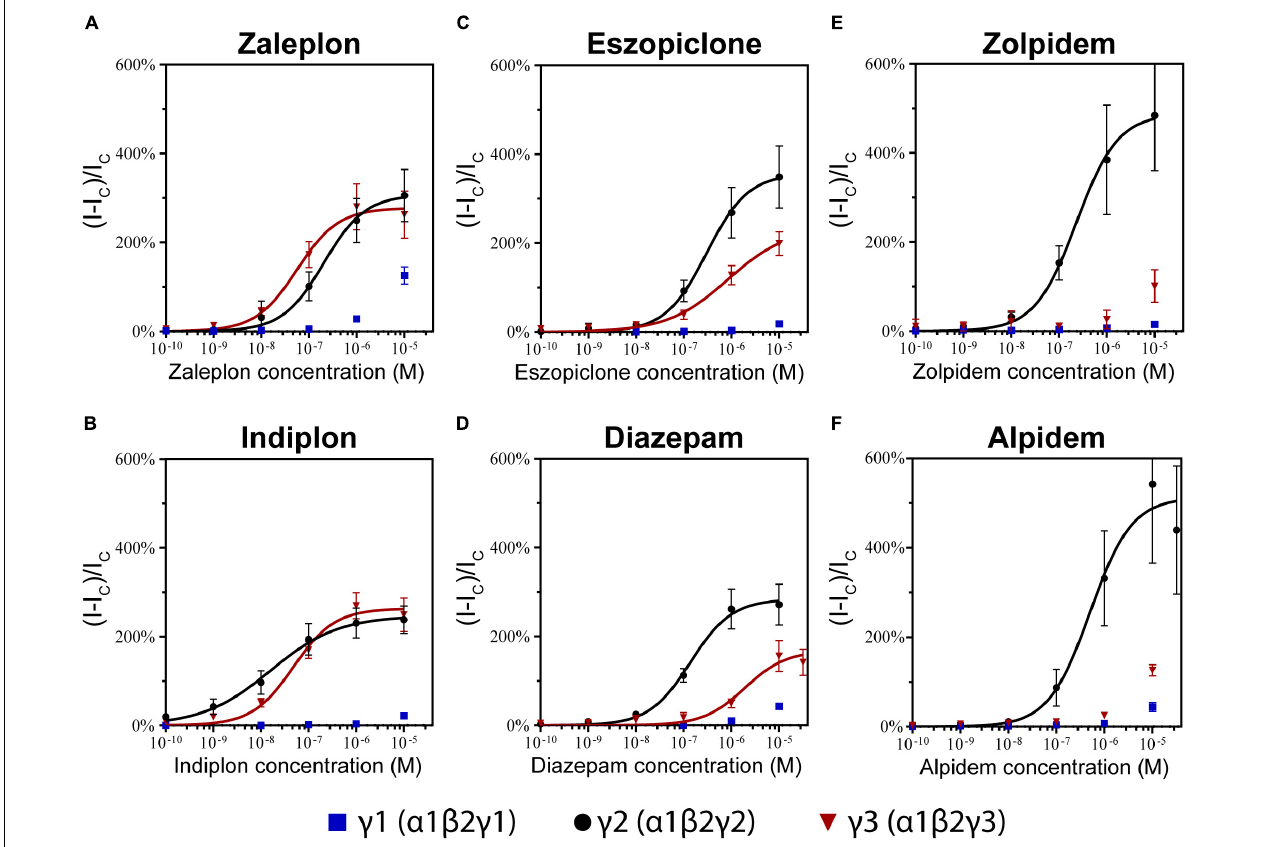
FIGURE 5 | Modulatory actions of (A) zaleplon, (B) indiplon, (C) eszopiclone, (D) diazepam, (E) zolpidem, and (F) alpidem, on GABA evoked Cl − currents measured in human α 1 β 2 γ 1, α 1 β 2 γ 2, and α 1 β 2 γ 3 GABA A receptors expressed in Xenopus laevis oocytes measured via two-electrode voltage-clamp. The data are expressed as a percentage potentiation of GABA EC 10 and are means ± SD ( n = 4–8 from at least 2 separate Xenopus laevis donors). Data points were fitted to the Hill equation with bottom set to 0 and slope constrained to